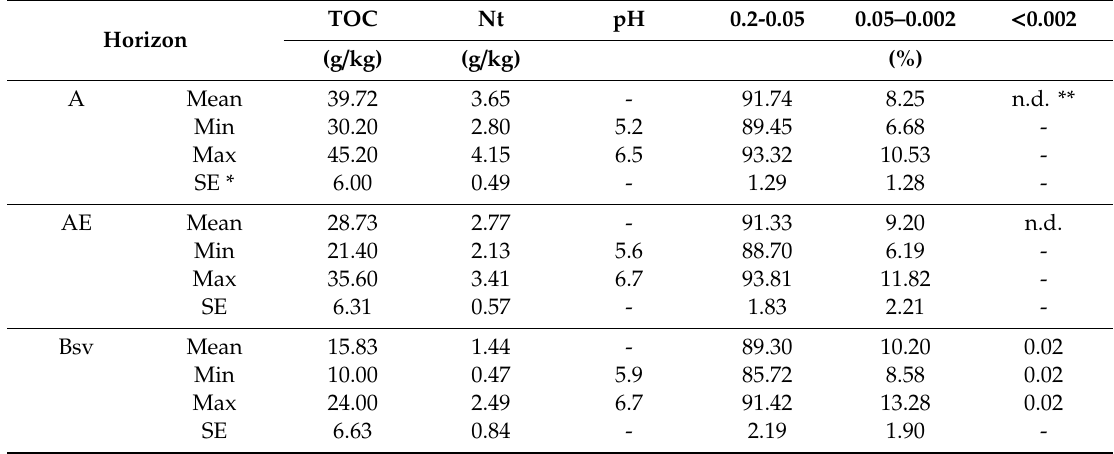
Table 4. Basic parameters of soils and grain size composition